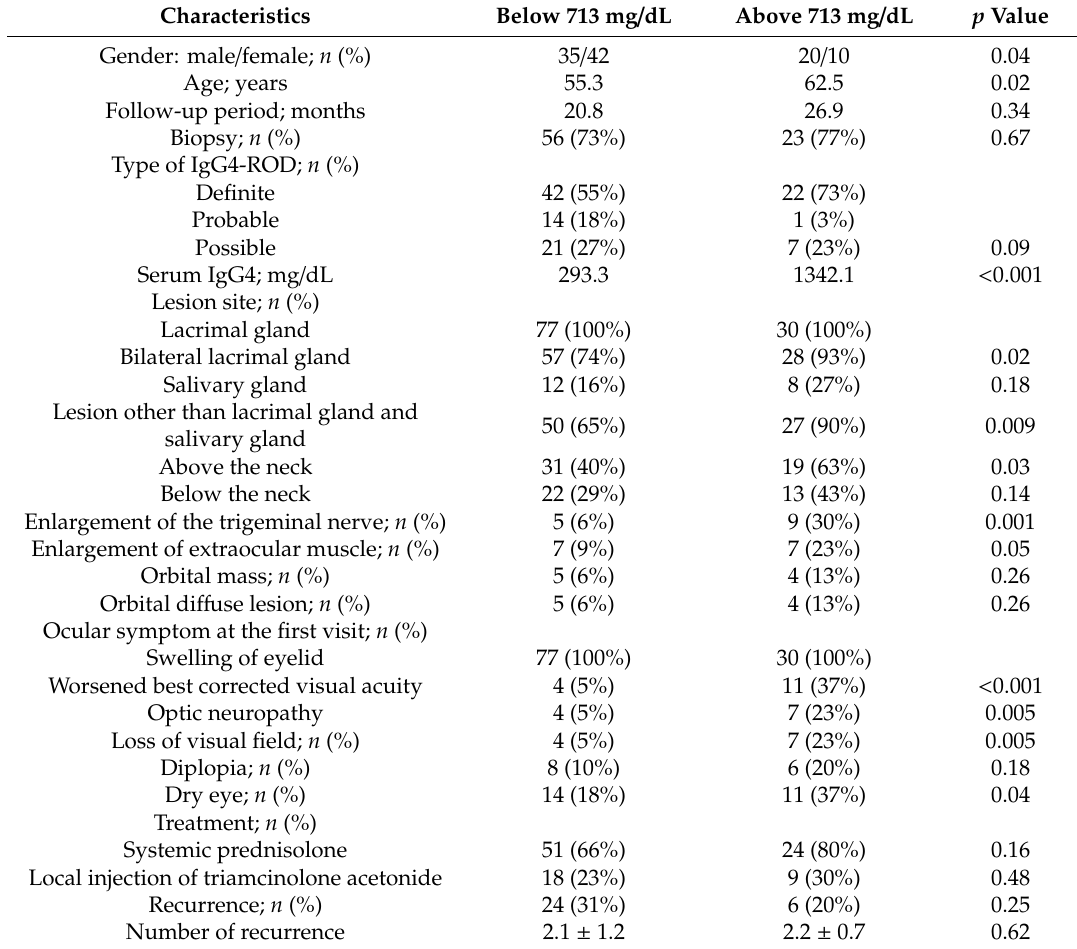
Table 9. Clinical findings in patients stratified by serum IgG4 concentration of 713 mg / dL. Characteristics Below 713 mg /